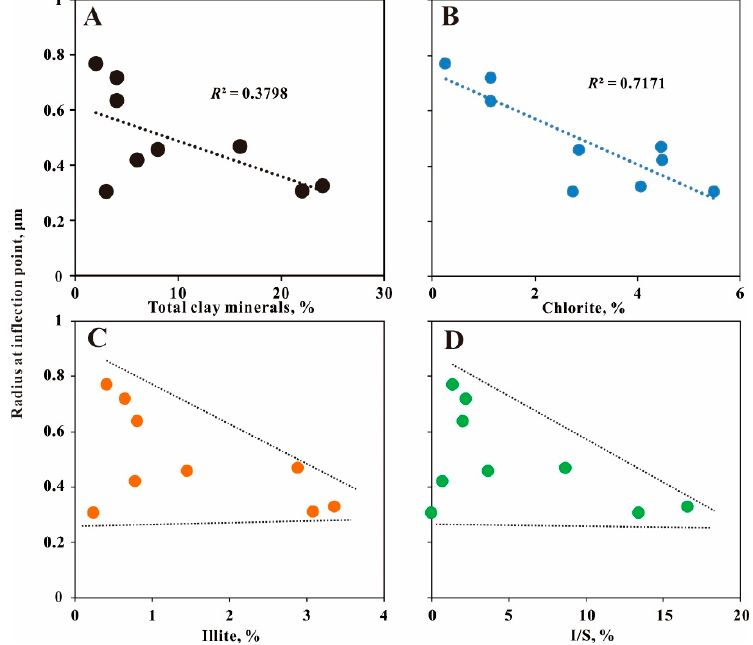
Figure 13. Throat radius at inflection point ( r ip ) vs. contents of total clay minerals ( A ), chlorite ( B ), illite ( C ), and I / S ( D